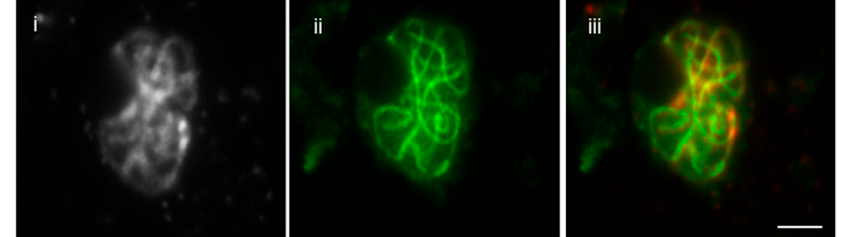
Figure 2. Immunolocalization of SYN1 in paraformaldehyde-fixed male meiocytes without enzymes. (i) DAPI-stained pachytene chromosome, (ii) SYN1 stained pachytene chromosome and (iii) Merged. Chromosomes are counterstained with DAPI (left image of each panel); Bar = 10 μ m.